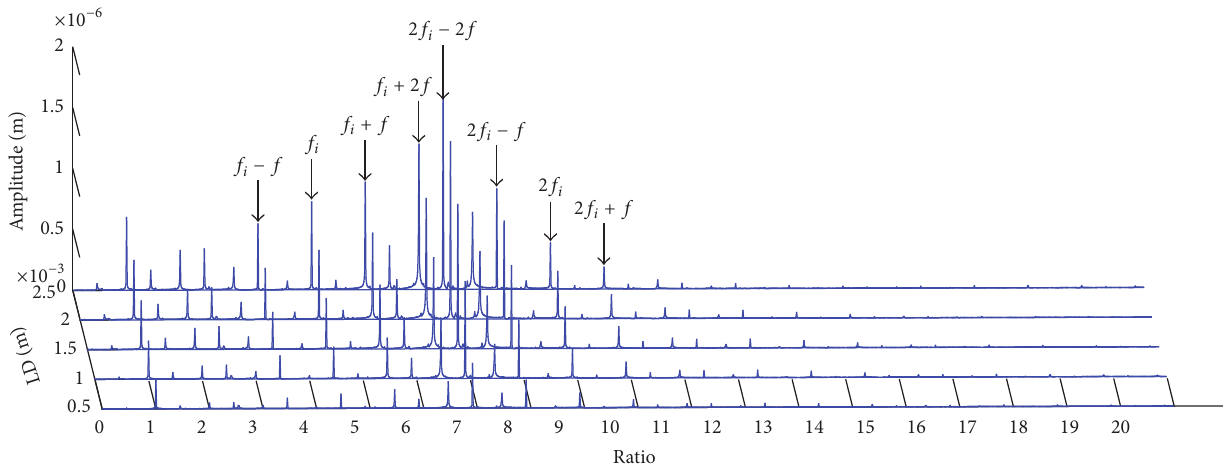
Figure 11: Waterfall plot of inner race defect bearing system with width of defect at 150rad/s.